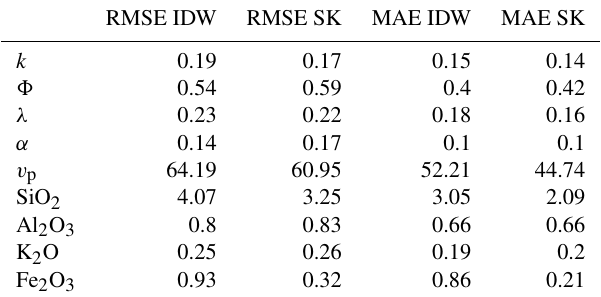
Table 1. RMSE and MAE for the interpolation results of IDW and SK for OSB1_c. k – permeability; (cid:56) – effective porosity; λ – ther- mal conductivity; α – thermal diffusivity; and v p – P-wave velocity.